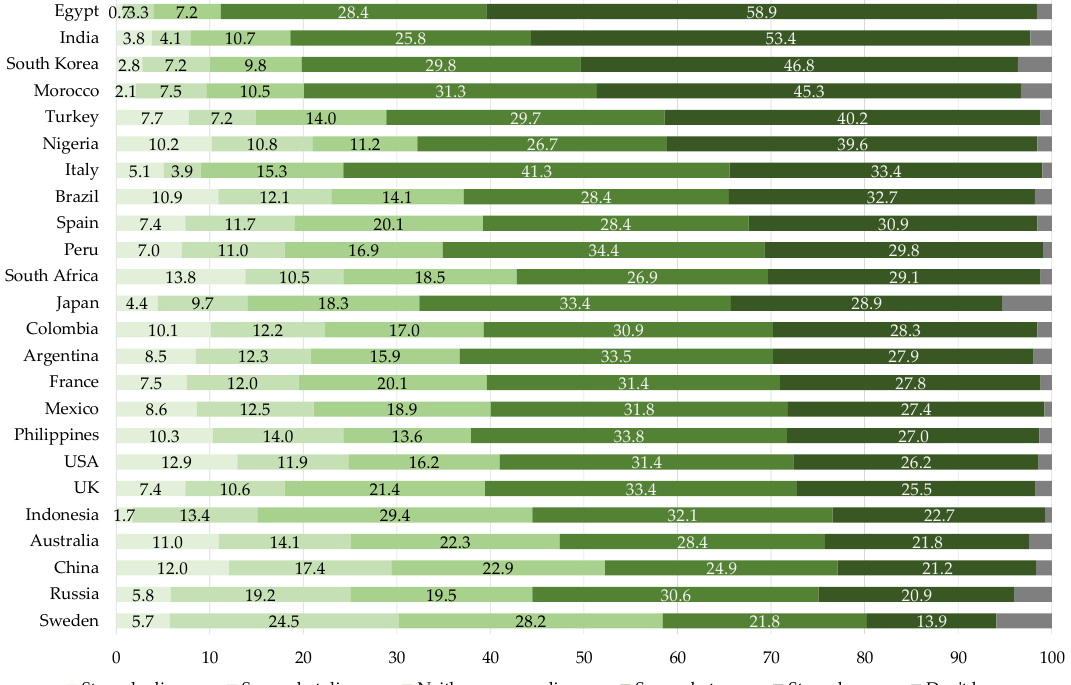
Figure 1. Responses (%) of the 23,482 young respondents to the international survey “Social Media & COVID-19” about the sentiment of agreement with three statements in 24 countries worldwide. Panel ( A ): I feel overwhelmed by the amount of information out there on COVID-19; Panel ( B ): I have stopped paying attention to news and information on COVID-19 in general; Panel ( C ): I am interested in news of a COVID-19 vaccine.